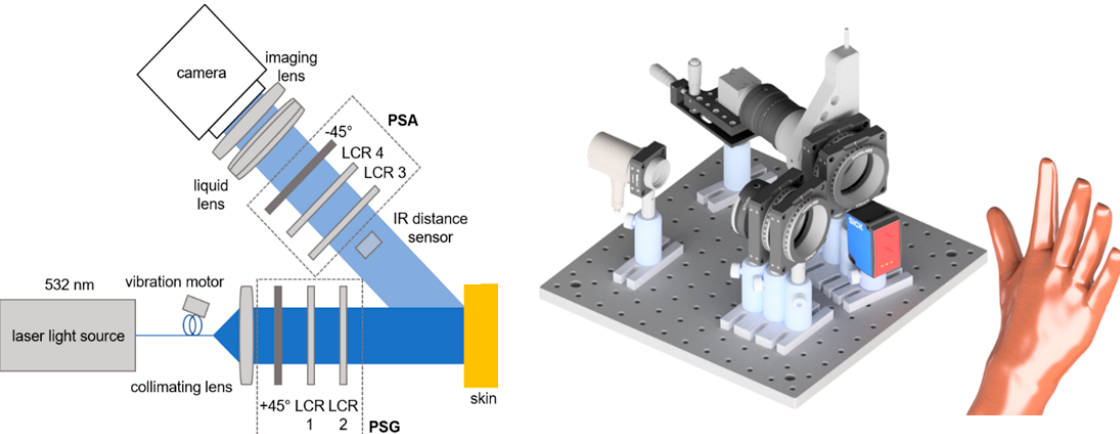
Figure 2. Sketch of Mueller matrix polarimeter. Left: 2D top view. Right: 3D side view rendering. The IR distance sensor is positioned below the beam path, not within it. The setup consists of the 532 nm continuous wave laser light source (CW532-04-1, ROITHNER LASERTECHNIK GmbH, Wien, Austria), liquid crystal retarder (LCC1223T, Thorlabs, Newton, NJ, USA), IR distance sensor (DT35-B15851, Sick AG, Waldkirch, Germany), liquid lens (EL-16-40-TC, Optotune AG, Dietikon, Schweiz) and CCD camera (BFS-U3-32S4M-C, FLIR Integrated Imaging Solutions Inc., Richmond, BC,